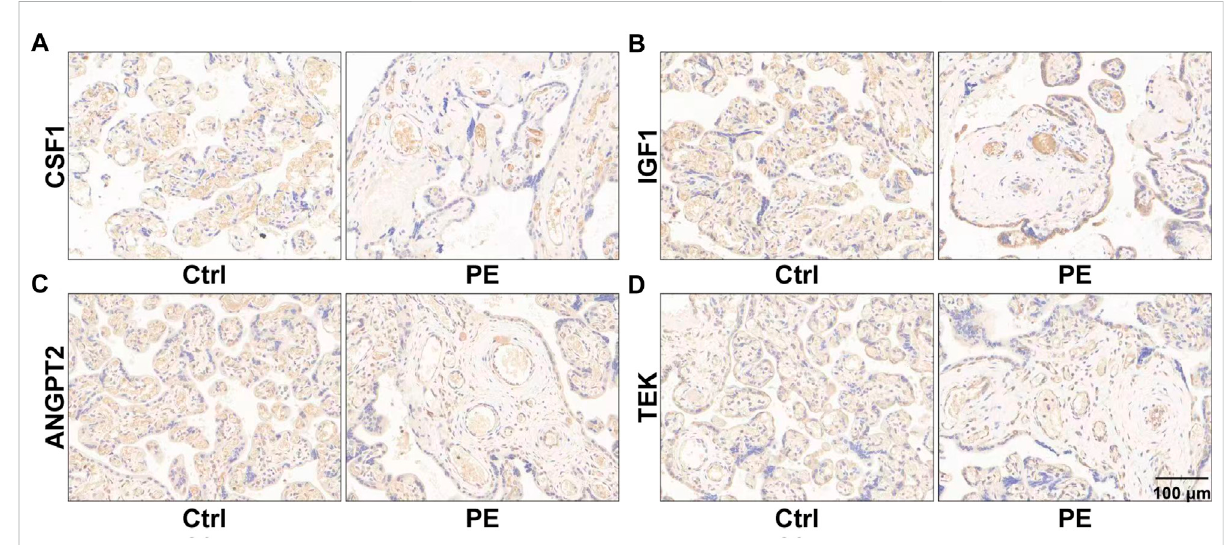
FIGURE 6 Images of immunohistochemistry showing the expression of placental CSF1 (A) , IGF1 (B) , ANGPT2 (C) , and TEK (D) in women with normal pregnancy and pre-eclampsia. The representative fi elds of the normal placenta for the control and lesion placenta for pre-eclampsia are